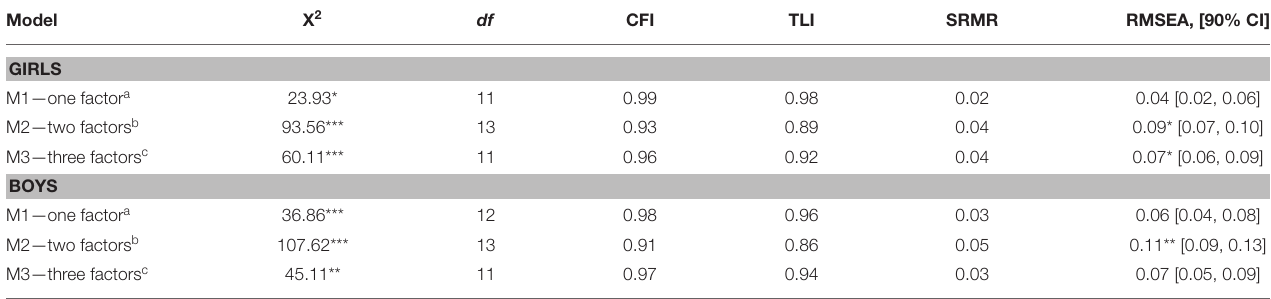
TABLE 4 | Model fit statistics for confirmatory factor analysis (CFA) of the STaS scale in gender groups. Model